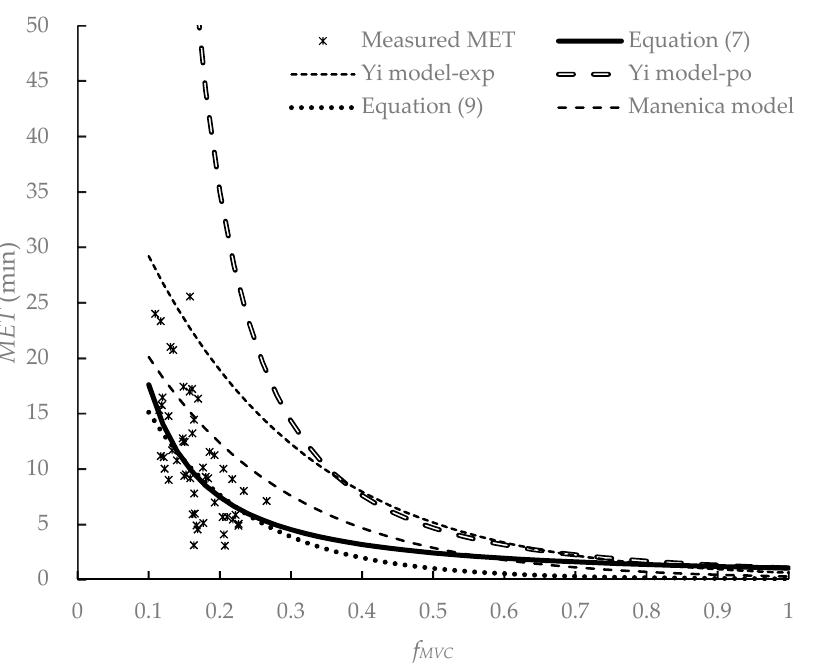
Figure 4. MET predictive models of muscle fatigue. Yi model-exp: MET model of the exponential function in Yi et al.; Yi model-po: MET model of the power function in Yi et al.; f MVC = forceful exertion/ MVC .